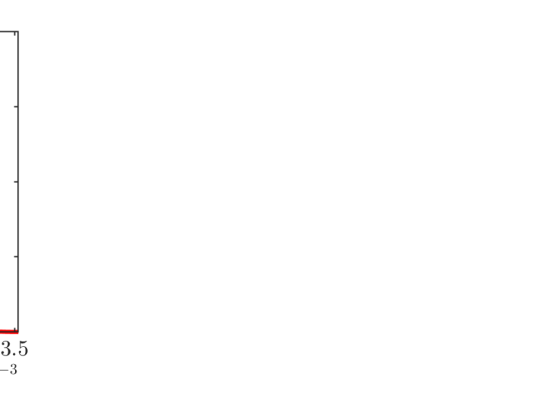
Figure A3. The T, S, N and 𝜎(𝑁) profiles with depth at CMP 1763. ( a ) Two hundred randomly drawn temperature profiles with depth. ( b ) Two hundred salinity profiles. ( c ) The smooth N profiles derived from T and S. ( d ) The standard deviation of N.